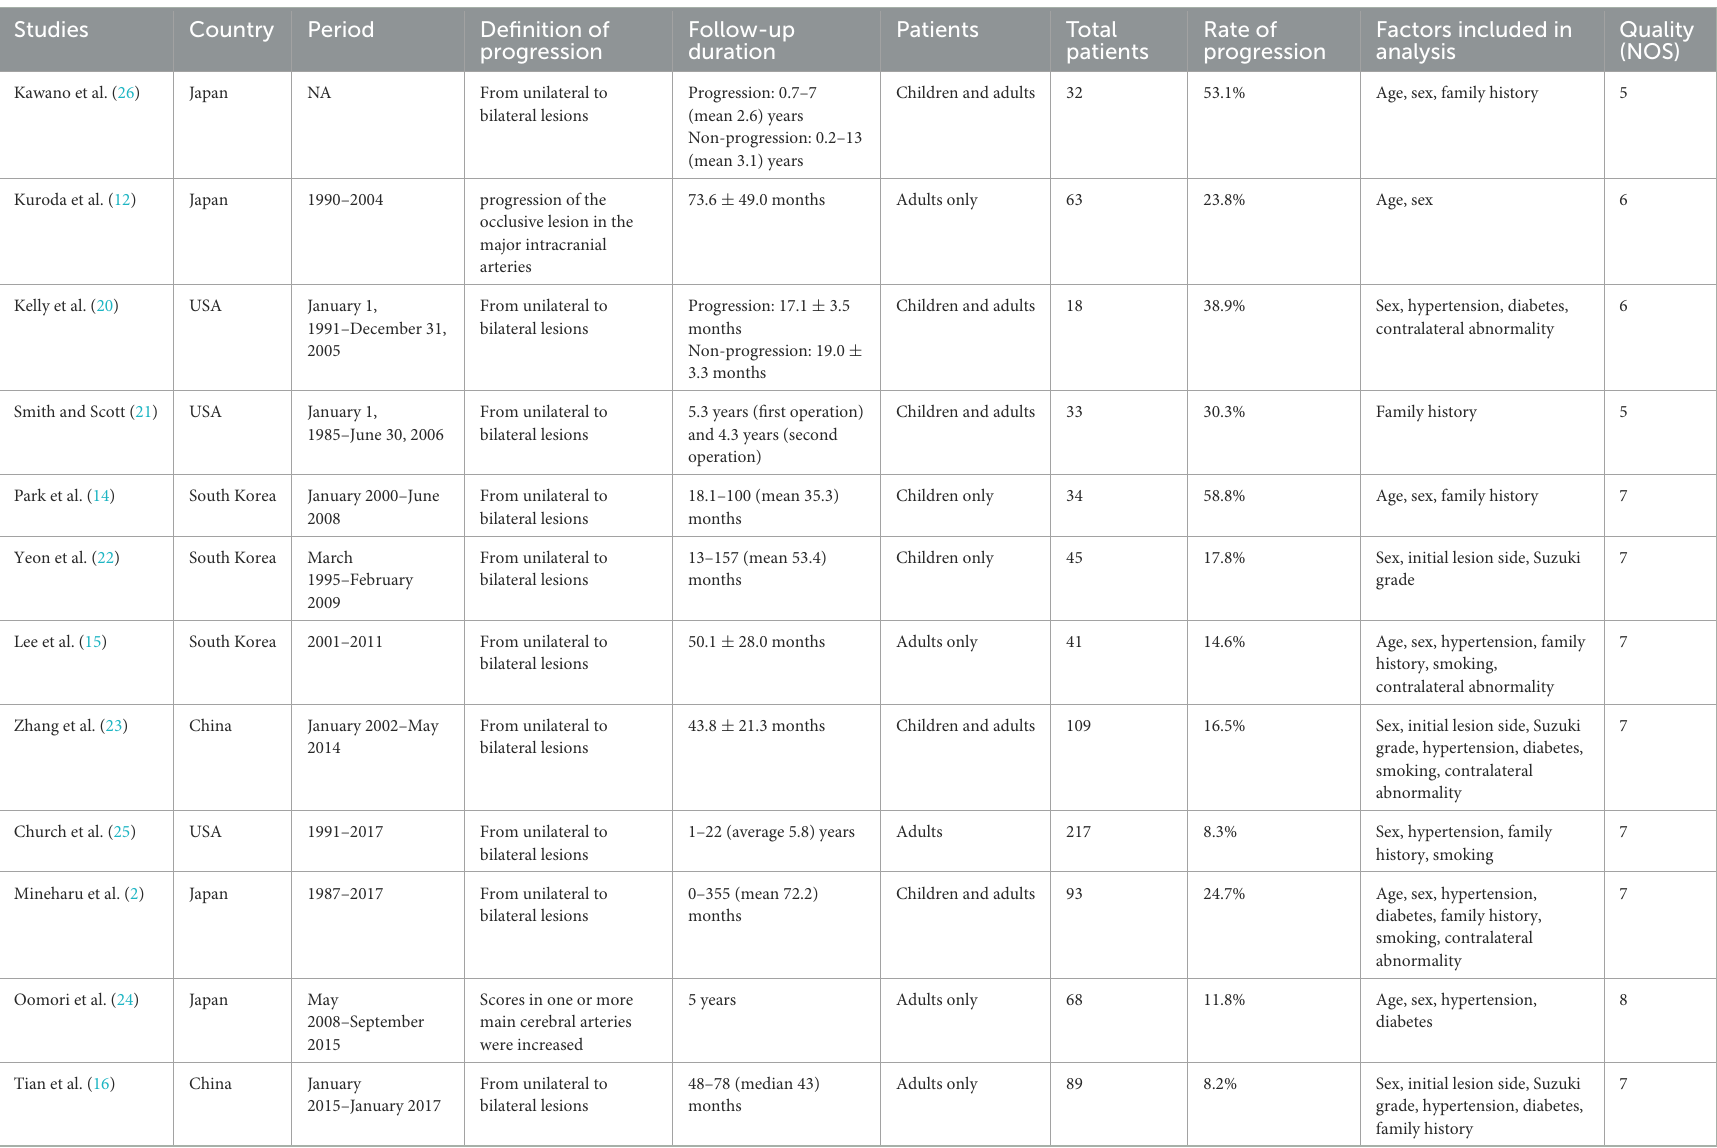
TABLE 1 Characteristics of included studies for progression of